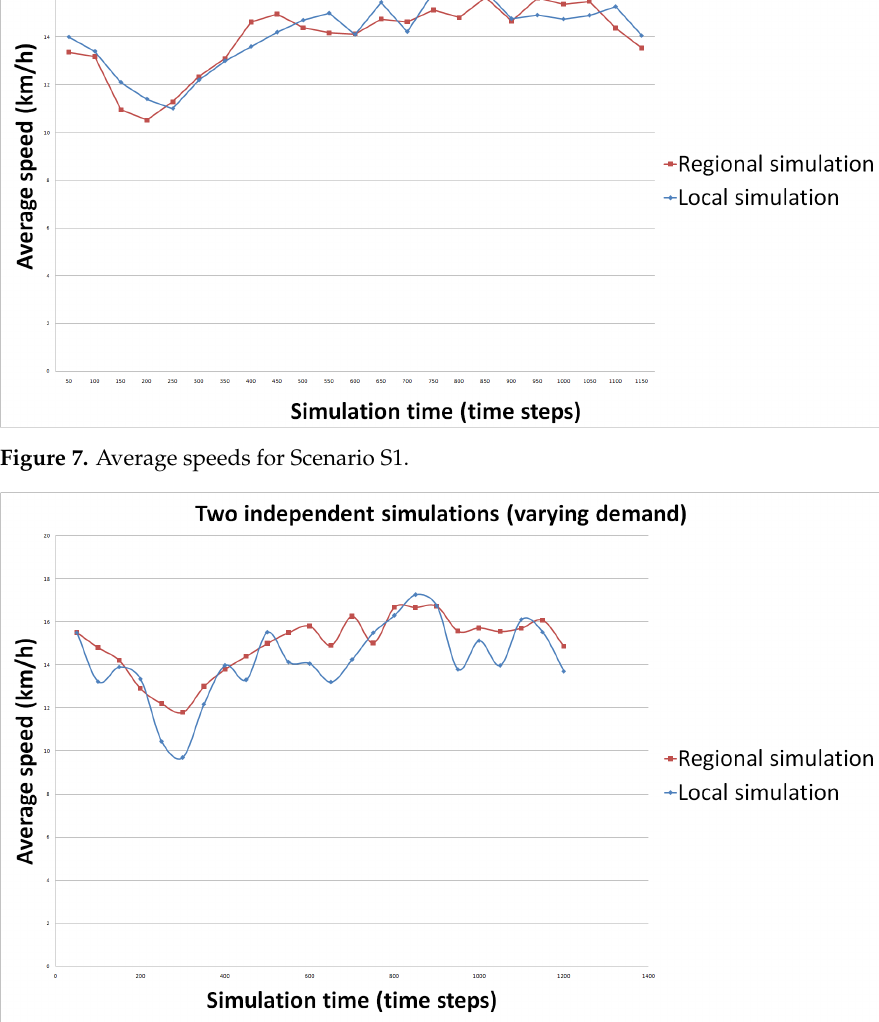
Figure 8. Average speeds for Scenario